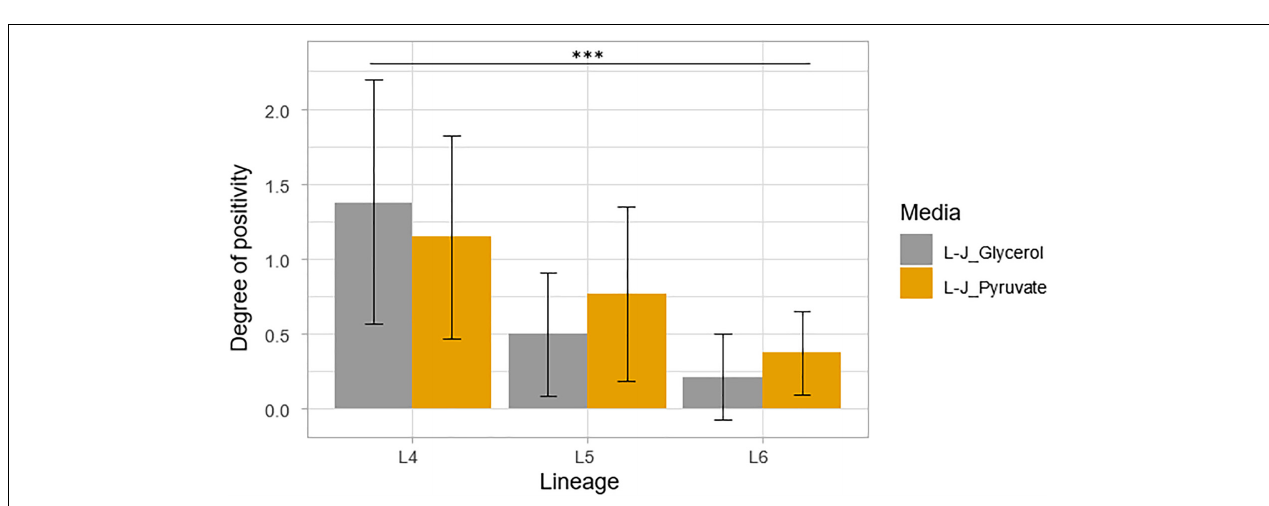
FIGURE 7 | Time to positivity on L-J media slants considering a larger sample size. The TTP of the three lineages was assessed for a previous study with a total of 2,219 isolates (L4 = 1,712, L5 = 306, and L6 = 201).